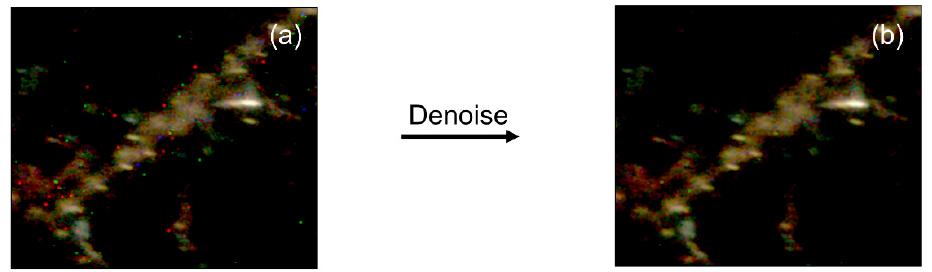
Figure 4. Comparison before ( a ) and after denoising ( b ).